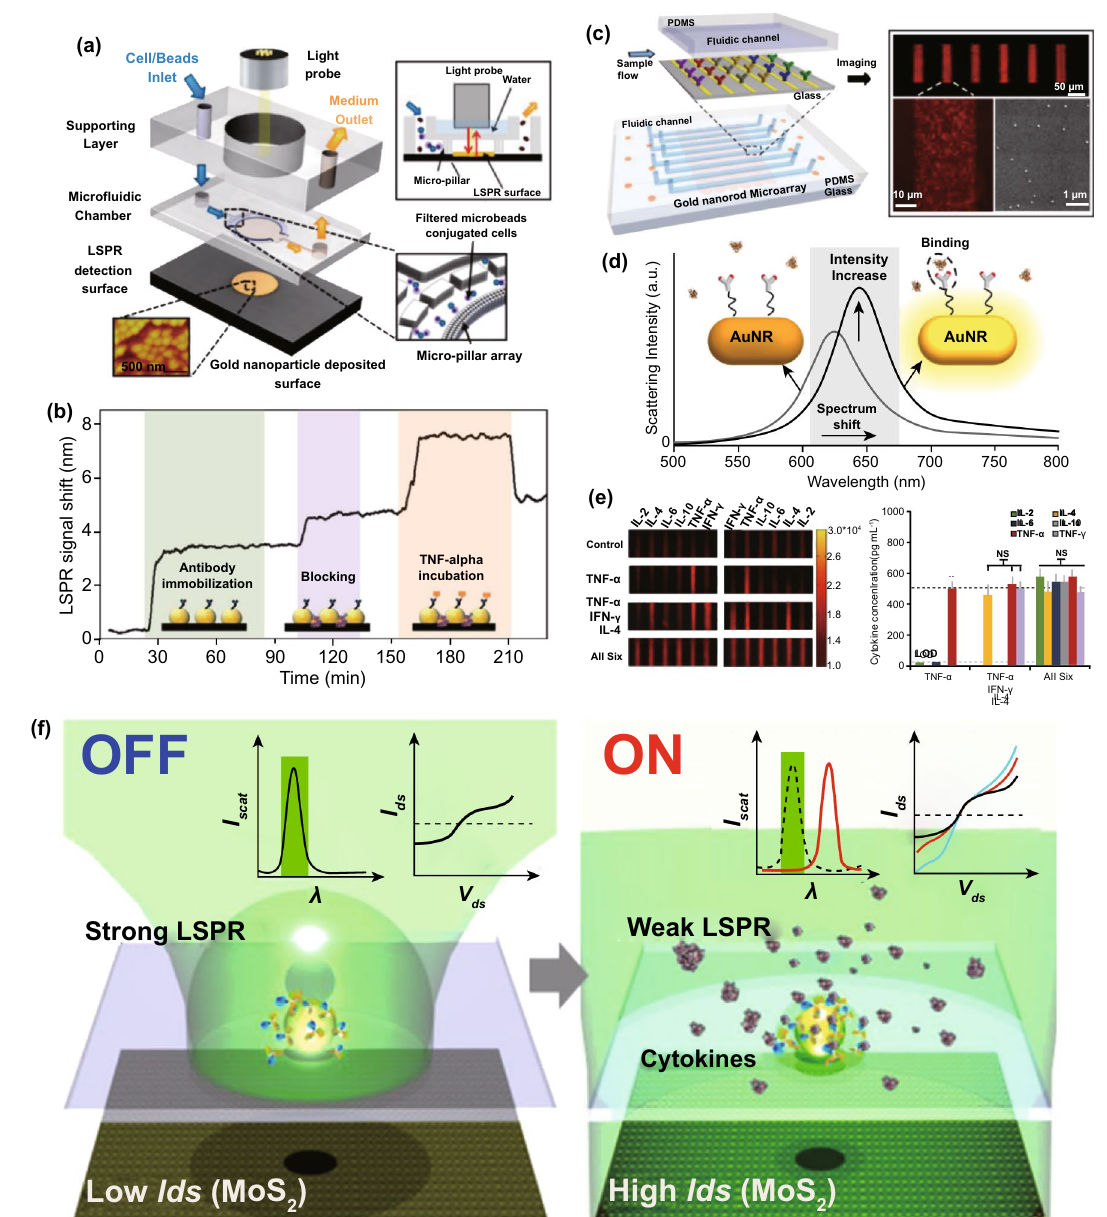
Fig. 11 Nanodiagnostic platforms based on nanoplasmonic technology for rapid, ultrasensitive, and/or real-time monitoring of cytokines. Opto- fluidic LSPR nanoplasmonic detector. a Schematic illustration of the organization of the optofluidic LSPR nanoplasmonic detector. b Real- time LSPR signal shift of the nanoplasmonic detector when sensing target molecules (TNF-α). Reproduced with permission from Ref. [161]. Copyright 2014 American Chemical Society. Multiplex LSPR nanoplasmonic biosensor. c Schematic illustration indicating the organization and detection mechanisms of the multiplex nanoplasmonic biosensor. d LSPR signal shift of antibody-coated AuNRs before or after the attach- ment of target cytokines. e Dark-field nanoplasmonic imaging and multiplex cytokine quantification of the multiplex nanoplasmonic biosensor microfluidic channels undergoing different sample mixtures of various cytokines. Reproduced with permission from Ref. [164]. Copyright 2015 American Chemical Society. f Biotunable nanoplasmonic filter combined with photoconductive materials for IL-1β detection. Reproduced with permission from Ref. [162]. Copyright 2017 American Chemical